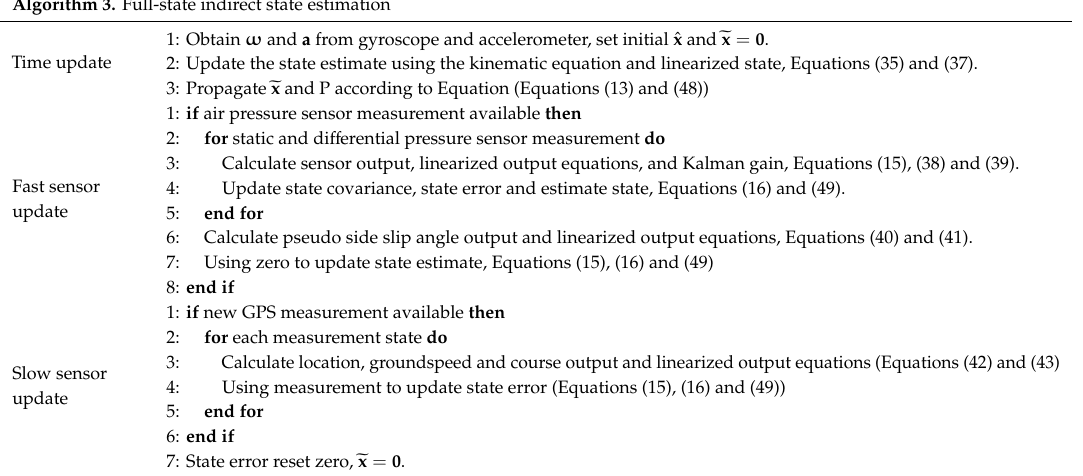
Algorithm 3. Full-state indirect state